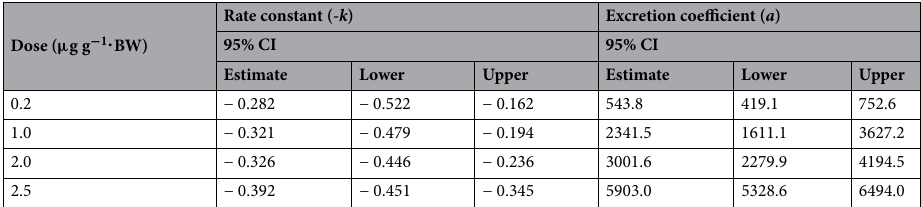
Table 1. Parameter estimates for first-order toxicokinetics excretion model (3) by imidacloprid dose 0.2 µ g g − 1 to 2.5 µ g g − 1 · Body Weight (BW). Parameter k is the excretion rate constant and parameter a is the dose-dependent excretion coefficient.